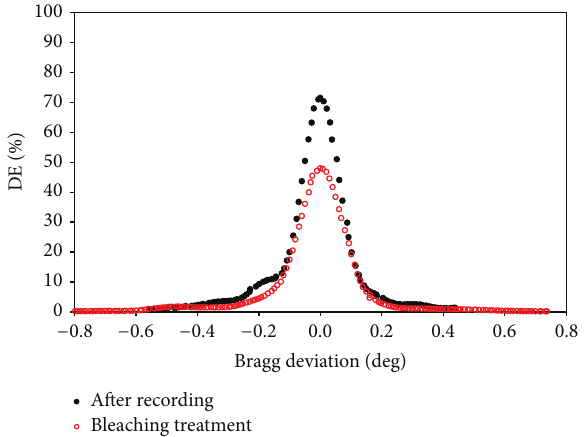
Figure 4: Angular scans after recording and after bleaching treat- ment for a photopolymer acrylamide based without